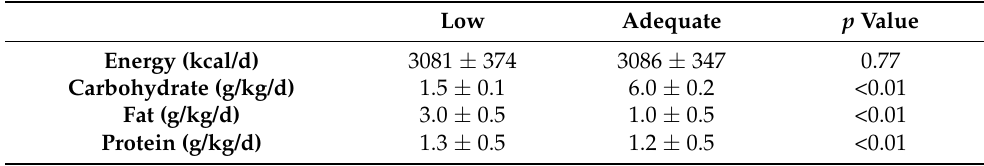
Table 1. Energy and relative macronutrient